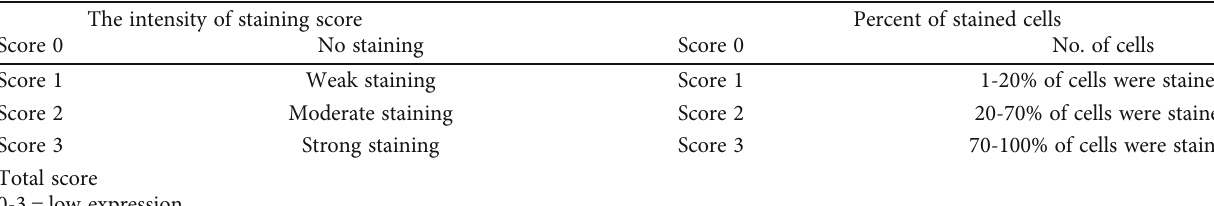
Table 1: Staining system of tumor cells for CD4, CD8, MMP9, and